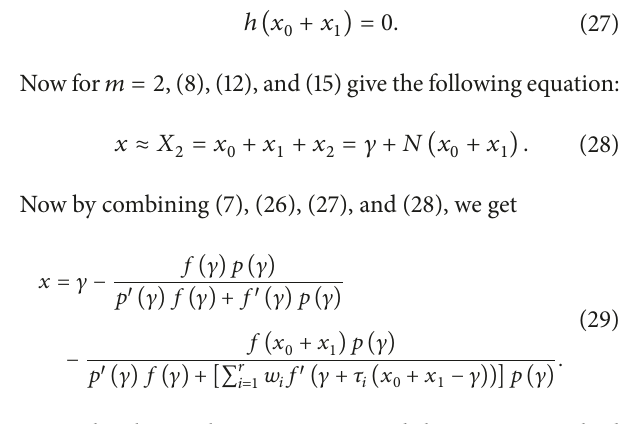
Algorithm 1 is suggested by M. A. Noor and K. I. Noor [8, 9] by the help of variational iterative